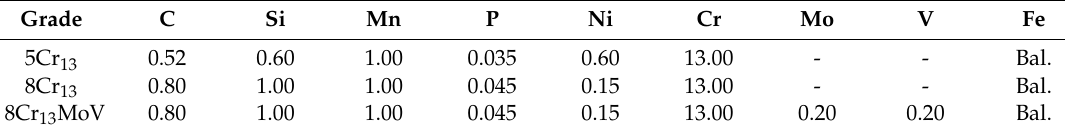
Table 2. Chemical composition of the surfacing materials in the present study